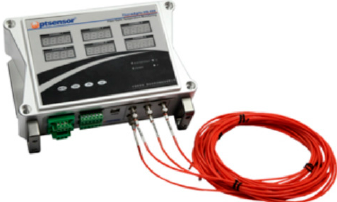
Figure 19. Optic fiber thermosensor. Energies 2019 , 12 , x